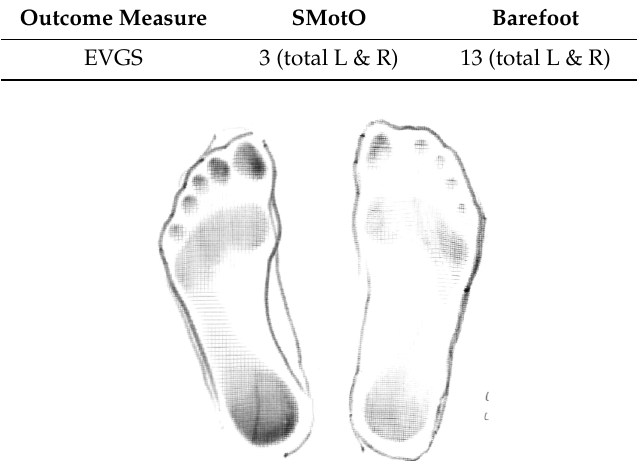
Table 8. Participant 7 EVGS results SMotO and barefoot. Figure 7. Participant 7. Figure 7. Participant 7.